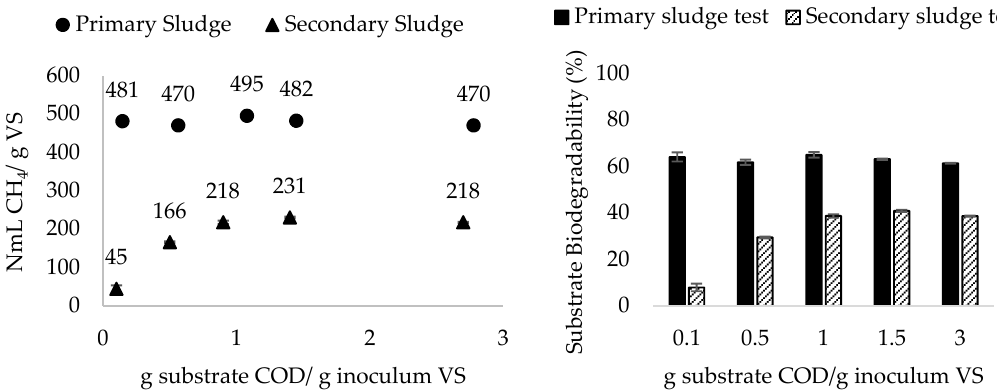
Figure 5. Left : Primary and secondary sludge ratio test methane yield results. Right : primary and secondary sludge biodegradability results for different SIR.